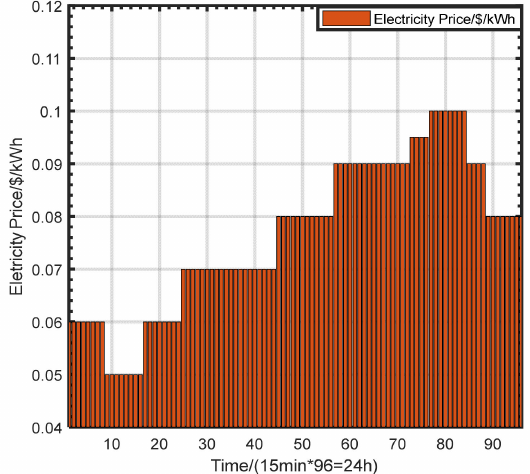
Figure A3. Electricity price. A 10 × 10 5G macro BS network .